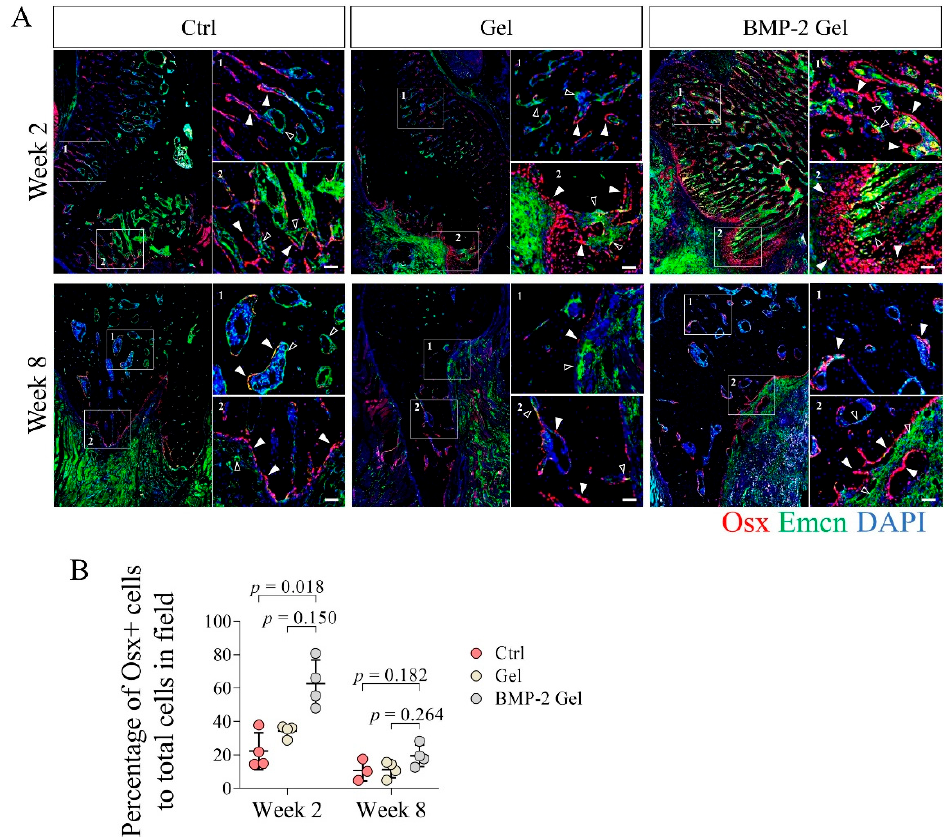
Figure 4. BMP-2 increased the number of osterix (Osx)+ osteoprogenitor cells coupled with vessels after implantation during the mandibular defect repair. ( A ) Immunofluorescent staining of Osx+ osteoprogenitor cells in the mandibular bone. Scale bar, 50 μ m. The white arrow indicates the Osx+ osteoprogenitor cells. The hollow arrow indicates the vessels. ( B ) Quantitative analysis of the number of Osx+ osteoprogenitor cells in the new bone. The p value was calculated by one-way ANOVA and Dunn’s multiple comparisons test.